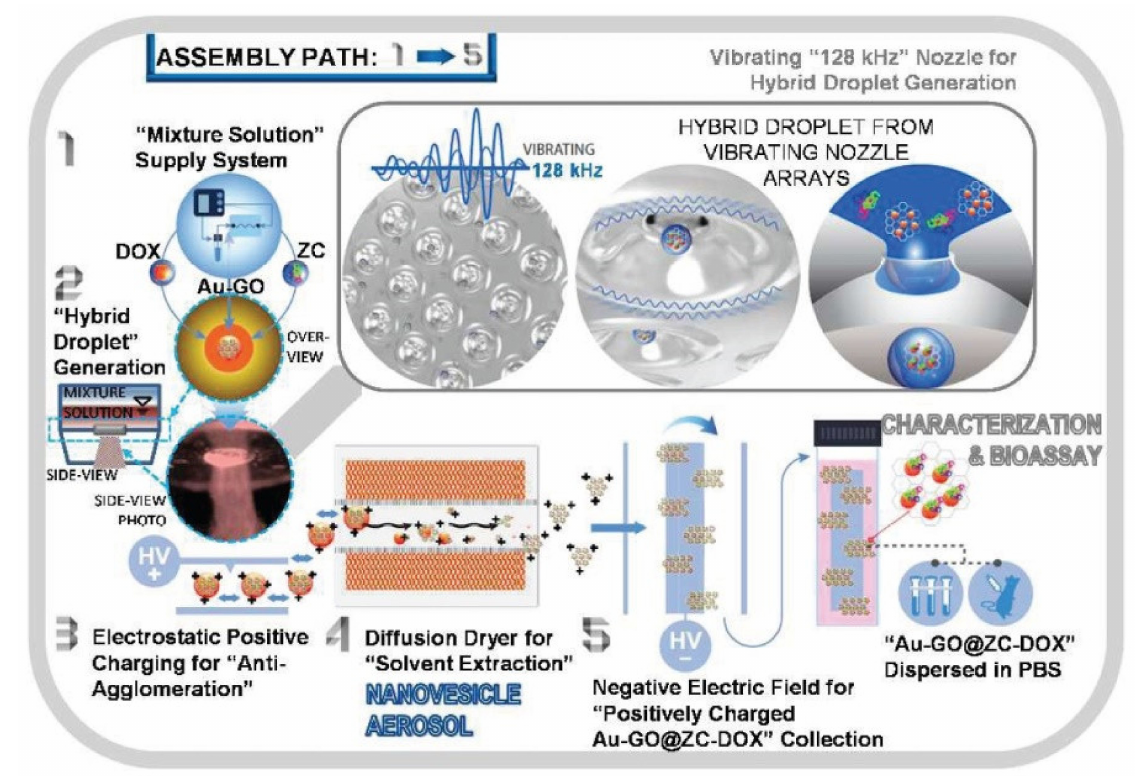
Figure 2. Assembly of the nanocomplex from gold–graphene, zwitterionic chitosan and doxorubicin, through a vibrating nozzle method. Step 1 is represented by the Au-GO being immersed in deionized water, together with ZC and DOX; step 2 is the connection of a vibrating nozzle to the bottle containing the complex to generate hybrid droplets; step 3—electrostatically charging the droplets; and step 4—generating the nanovesicles by passing the complex formed in step 3 through a diffusion dryer which detaches the solvent. Step 5—accumulating the nanovesicles on negative electric aluminum fields. Abbreviations: Au-GO, gold–graphene oxide; DOX, doxorubicin; ZC, zwitterionic chitosan. Reprinted with permission from